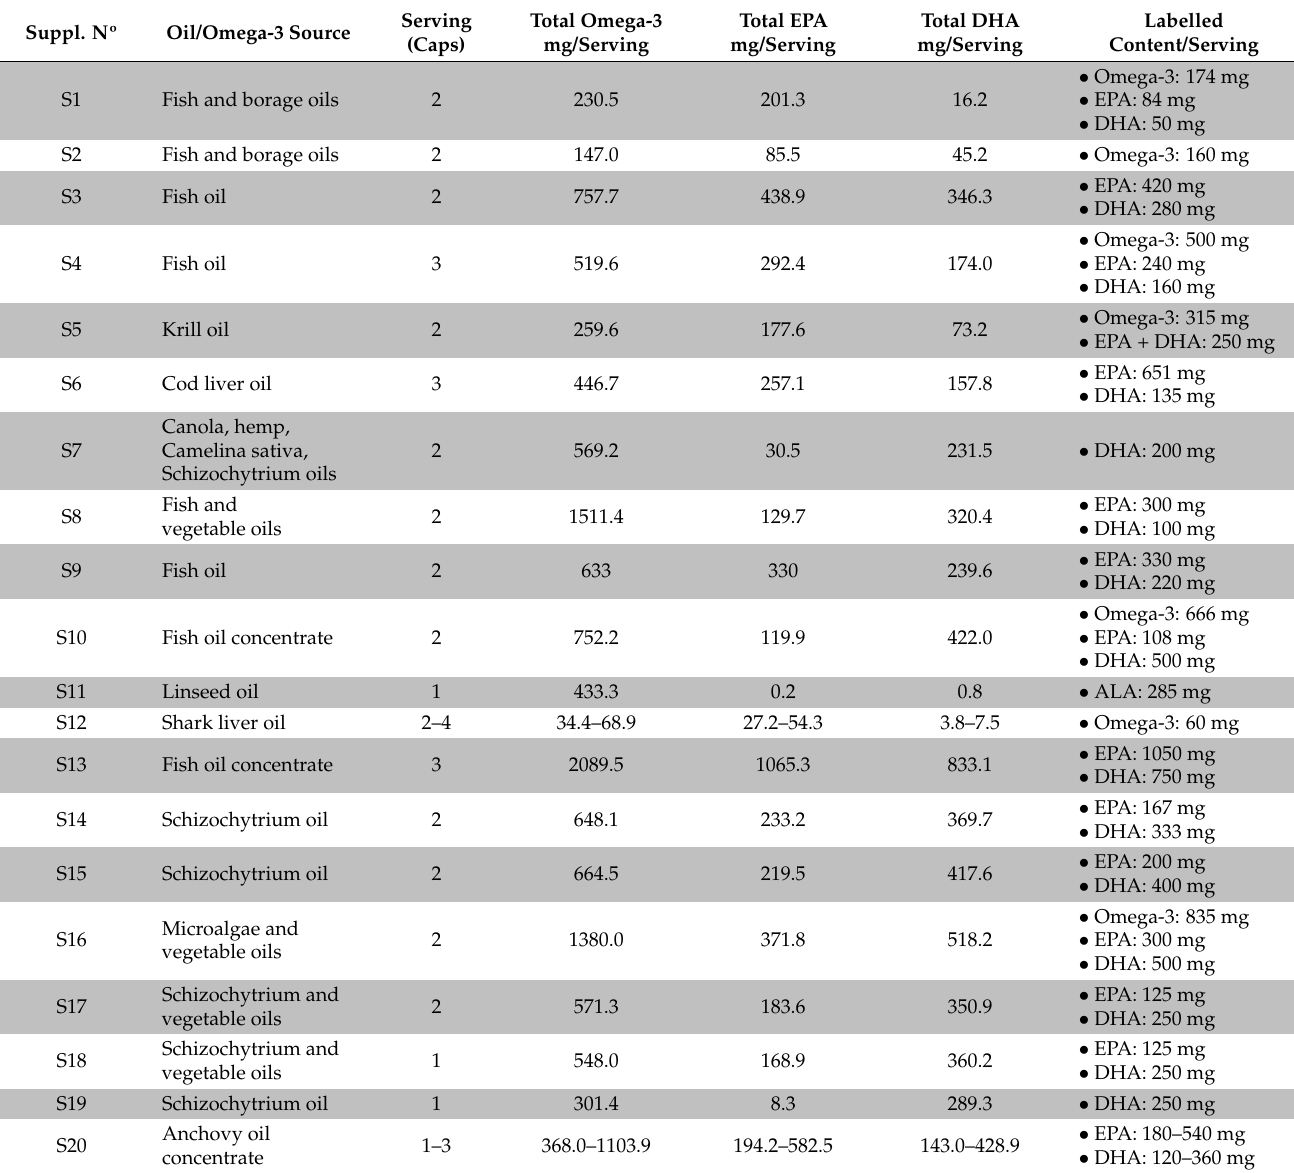
Table 1. Total omega-3, EPA, and DHA content (mg/serving) in the omega-3 supplements and comparison with the amounts declared in the